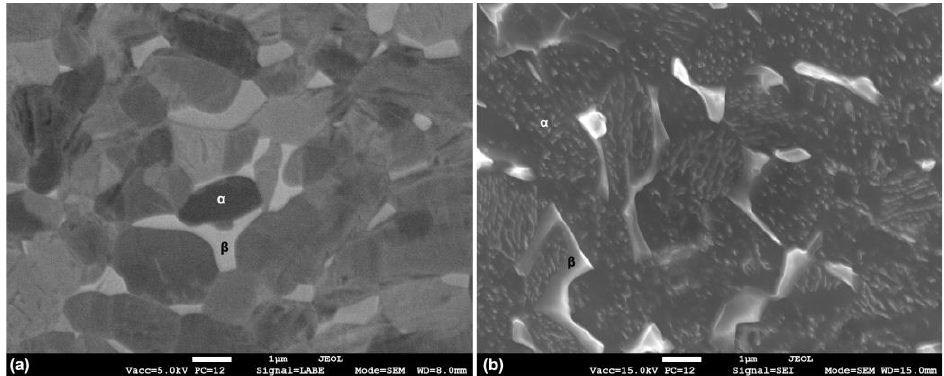
Figure 1. FESEM micrographs of the bare Ti6Al4V sample: ( a ) BSE micrograph, ( b ) SE micrograph after metallographic etching (Kroll’s solution 15 s). Table 1. EDXS analyses results in %wt. (Figure 1a).